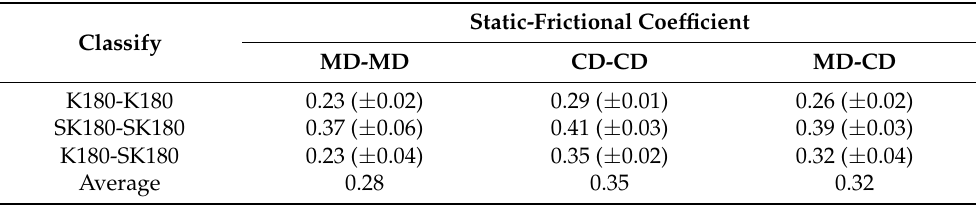
Static-Frictional